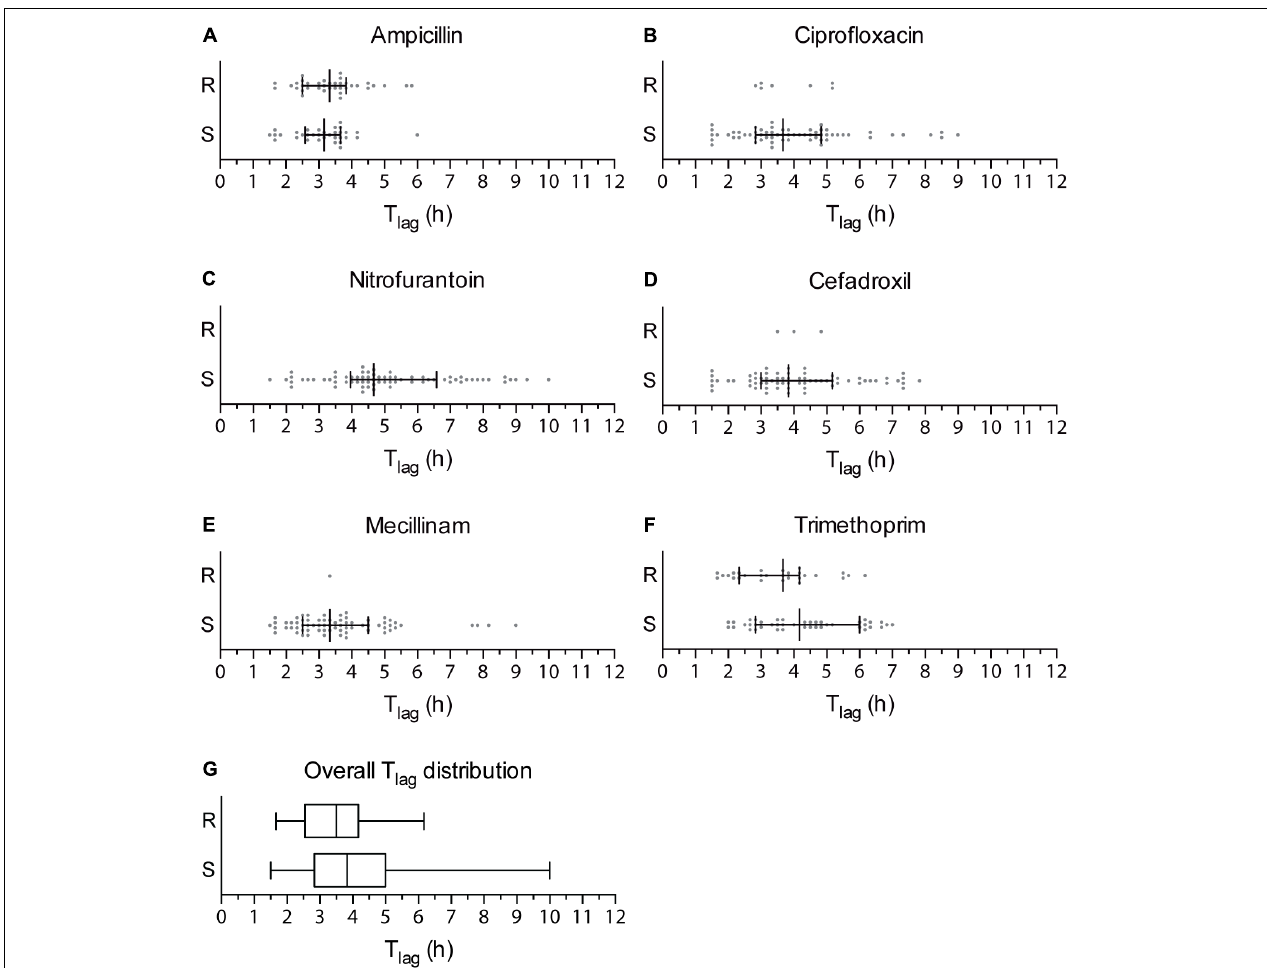
FIGURE 2 | T lag distribution of clinical UPEC isolates. (A–F) Dot plots showing the T lag generated by each of the 70 clinical UPEC isolates at the highest antibiotic concentration they were able to grow at. Strains are grouped as resistant strains (R), which generated a T lag above the clinical breakpoint, and susceptible strains (S), which generated a T lag below the clinical breakpoint of each antibiotic. Median is shown with whiskers drawn at the 25 th and 75 th percentile. (G) Box plots showing the overall distribution of T lag values obtained for resistant (R) and sensitive (S) strains irrespective of the type of antibiotic. Whiskers show the minimum and maximum value of T lag